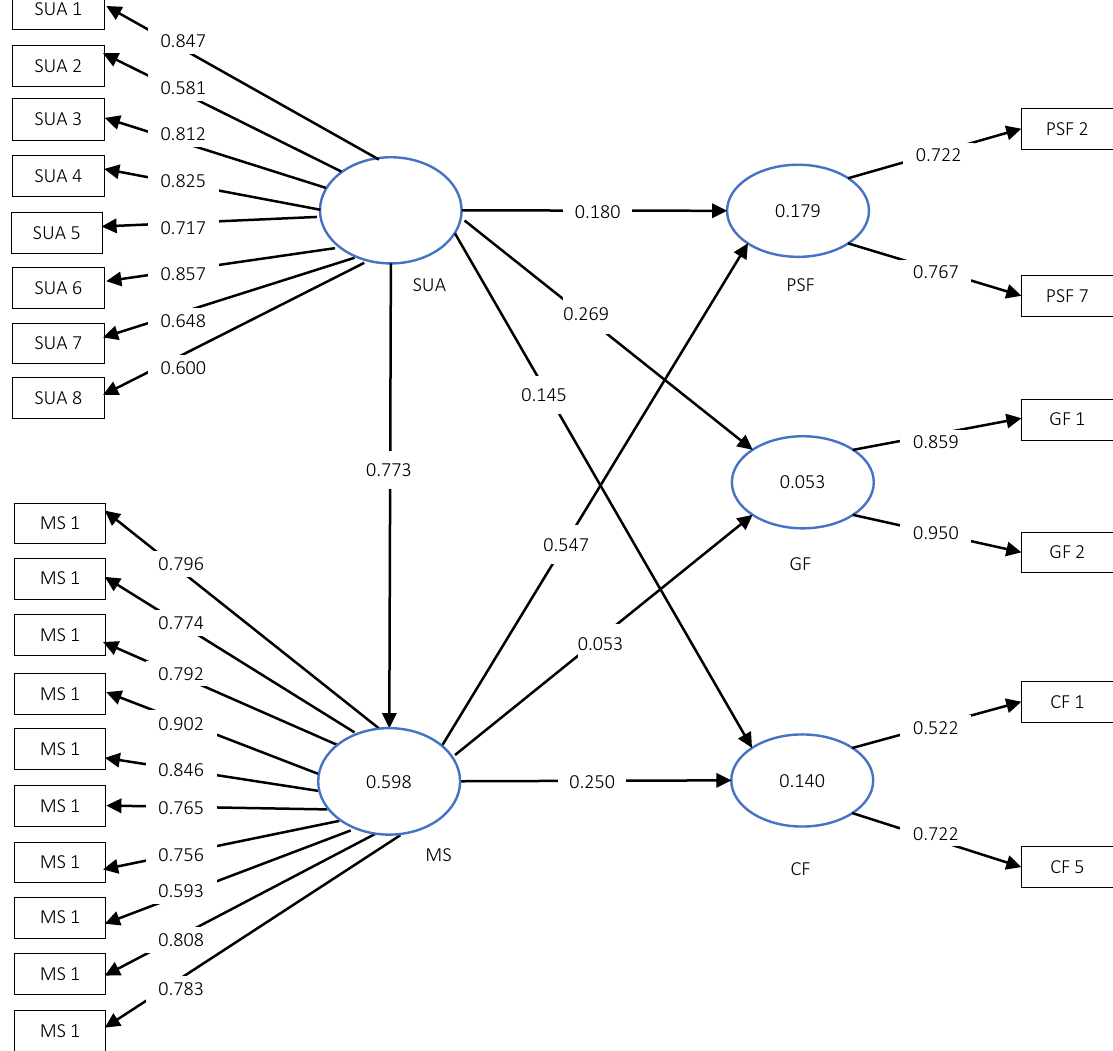
Figure 1. Structural model